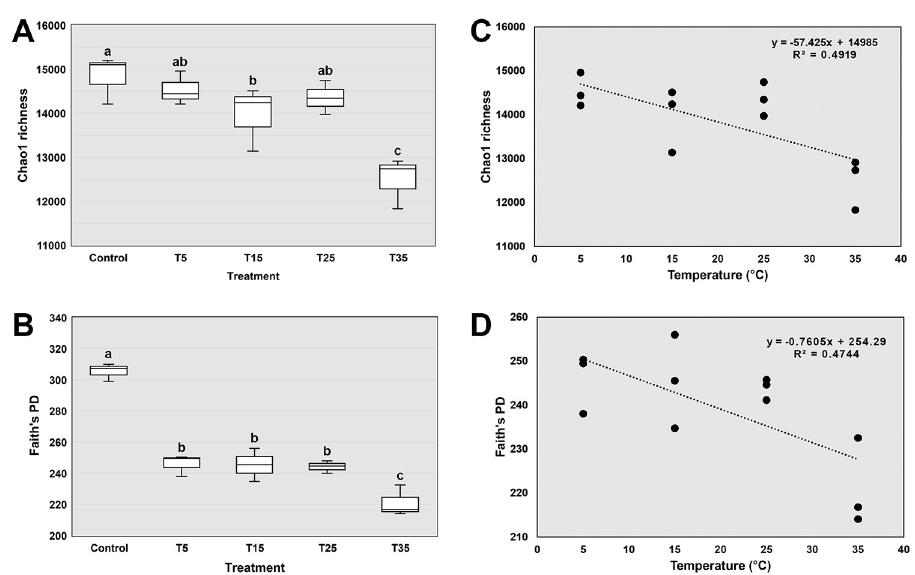
Fig 3. Bacterial diversities and their correlation with temperature. (A) Chao1 richness of rhizosphere bacterial communities. (B) Faith’s phylogenetic diversity of rhizosphere bacterial communities. Same alphabets above the box indicate no significant difference between treatments (detected by Kruskal-Wallis test at 0.05 level). (C) The correlation between temperature and Chao1 richness. (D) The correlation between temperature and Faith’s phylogenetic diversity.